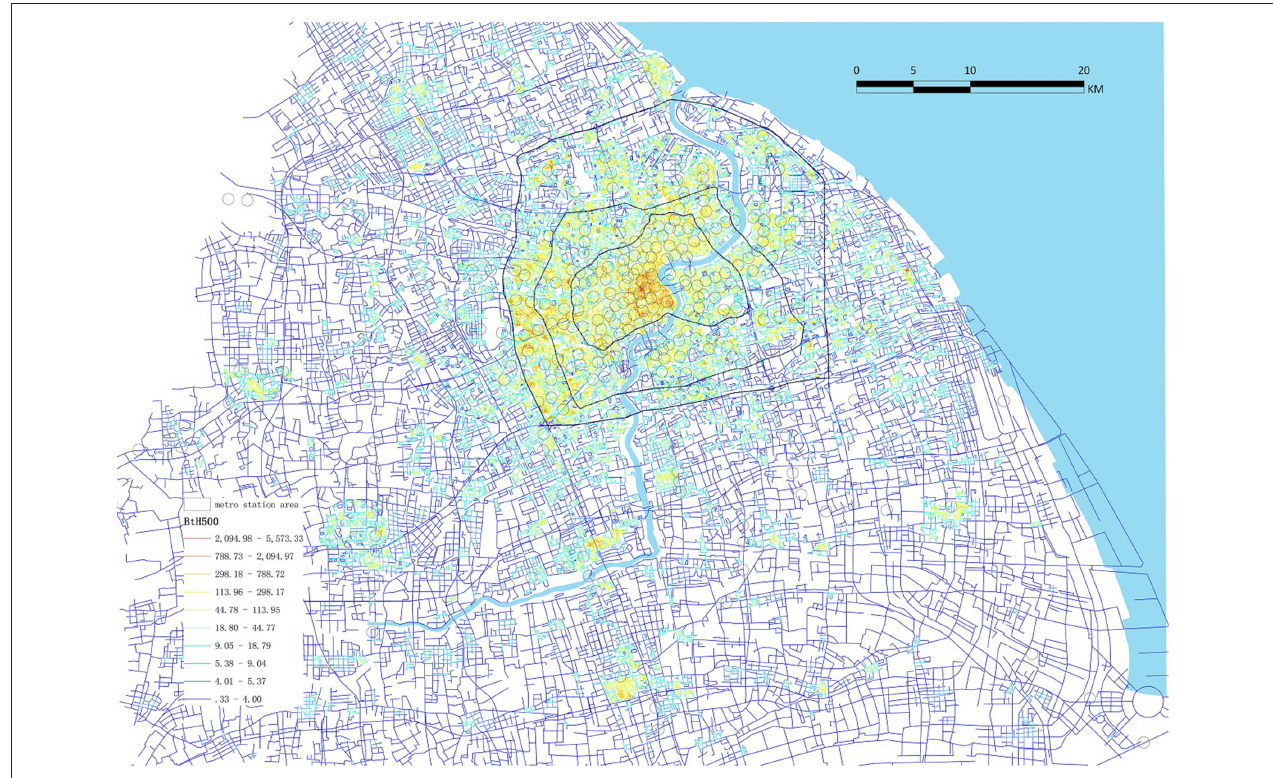
FIGURE 4 | Hybrid betweenness centrality of the pedestrian network by the software sDNA (radius at